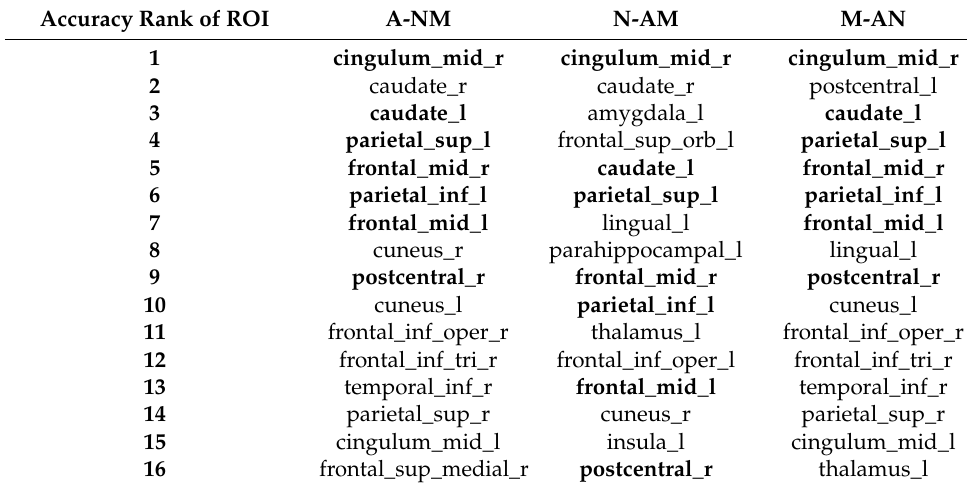
Table 4. 16 Selected discriminative ROIs for three AD assessments.